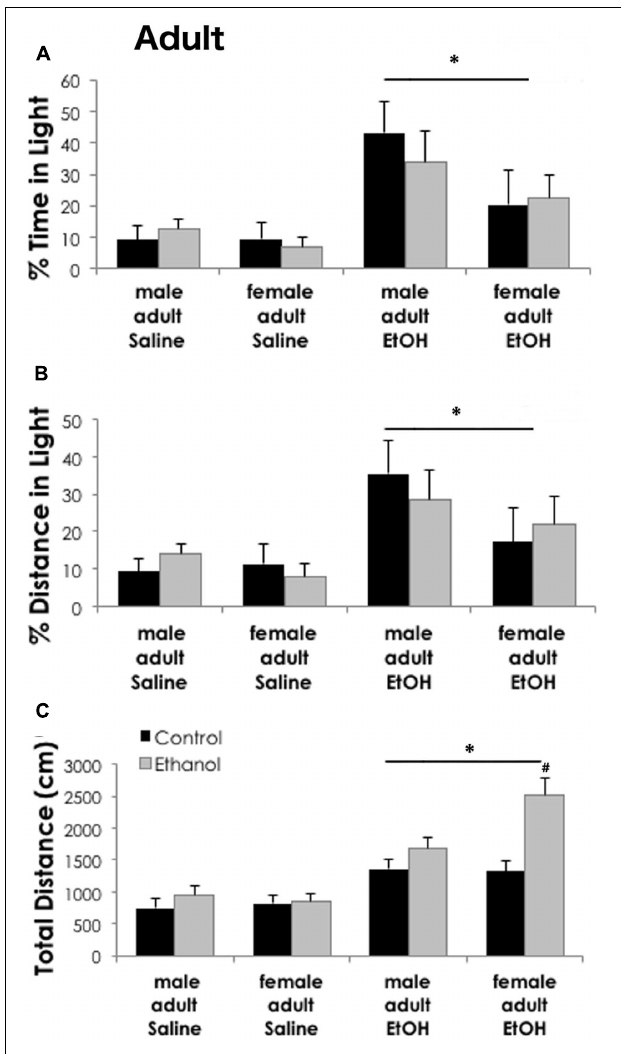
FIGURE 4 | Binge ethanol does not alter ethanol-induced anxiolysis in adulthood. Ethanol (2 g/kg i.p.) significantly increased time spent in the light (A) and distance traveled in the light (B) as compared to adult saline treated mice ( n = 5–10/group). Sex differences or prior exposure to ethanol did not modify anxiety-like behavior in the light–dark box. (C) Total distance traveled during the task was higher in ethanol treated mice. Females previously exposed to ethanol during adolescence had significantly higher locomotor activity as compared to all other groups. Data is presented as mean +/– SEM. ∗ p < 0.05, main effect of ethanol injection by Three-Way ANOVA. # p < 0.05 for interaction between adolescent exposure, ethanol injection and sex by Three-Way